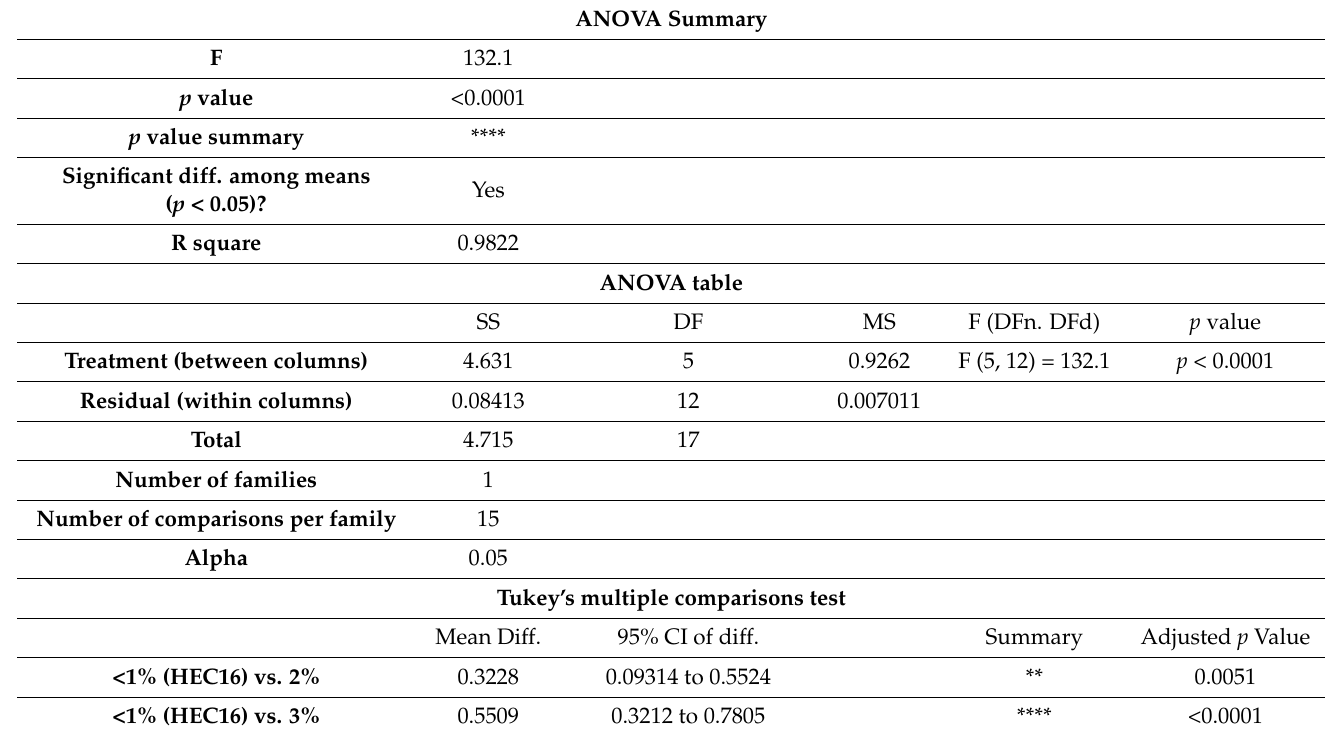
Table A5. One-way ANOVA analysis and Tukey’s multiple comparisons test to evaluate the effect of different salinity values on T/C. p > 0.0123 = not significant (ns); p < 0.033 = *; p < 0.0021 **; p < 0.0001 = ****.